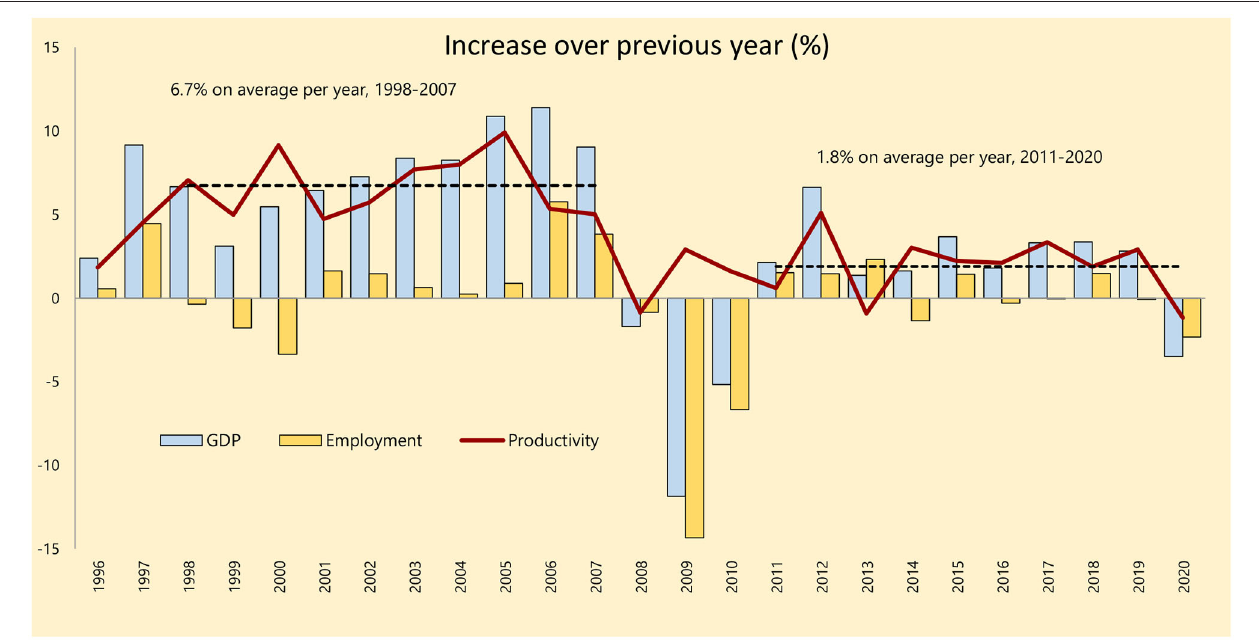
FIGURE 8 | Annual productivity growth rates in Latvia (16). Source: author’s construction based on the Eurostat data, 2021.